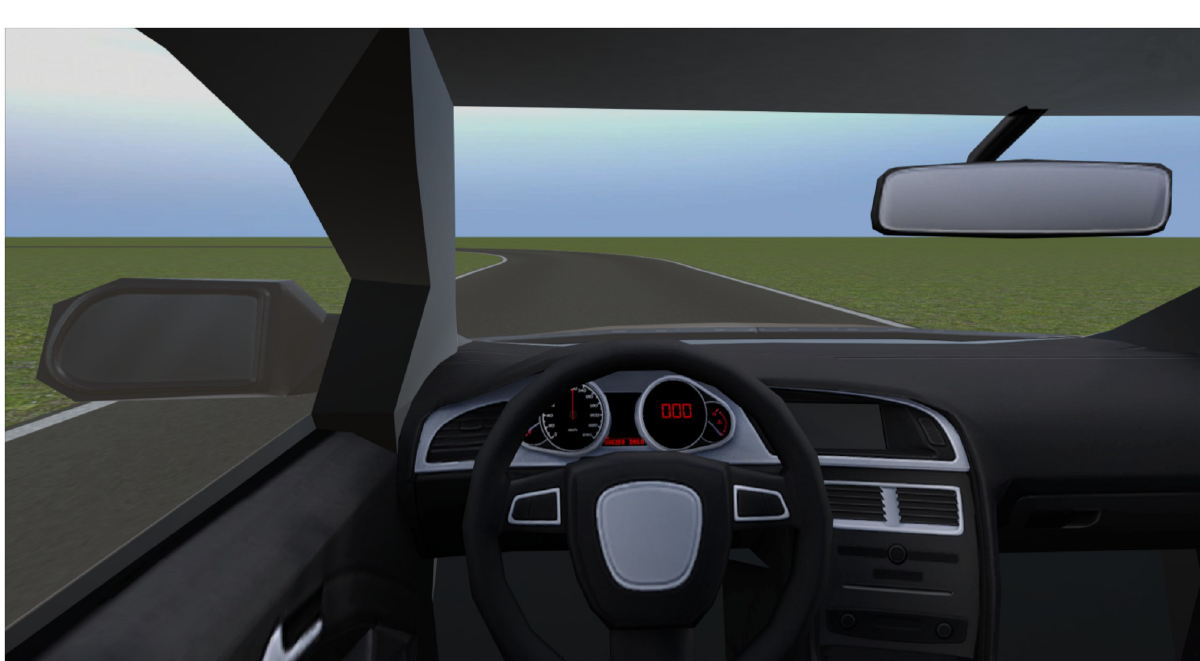
Fig 3. View from HMD. Screenshot of the view participants had from the inside of the virtual